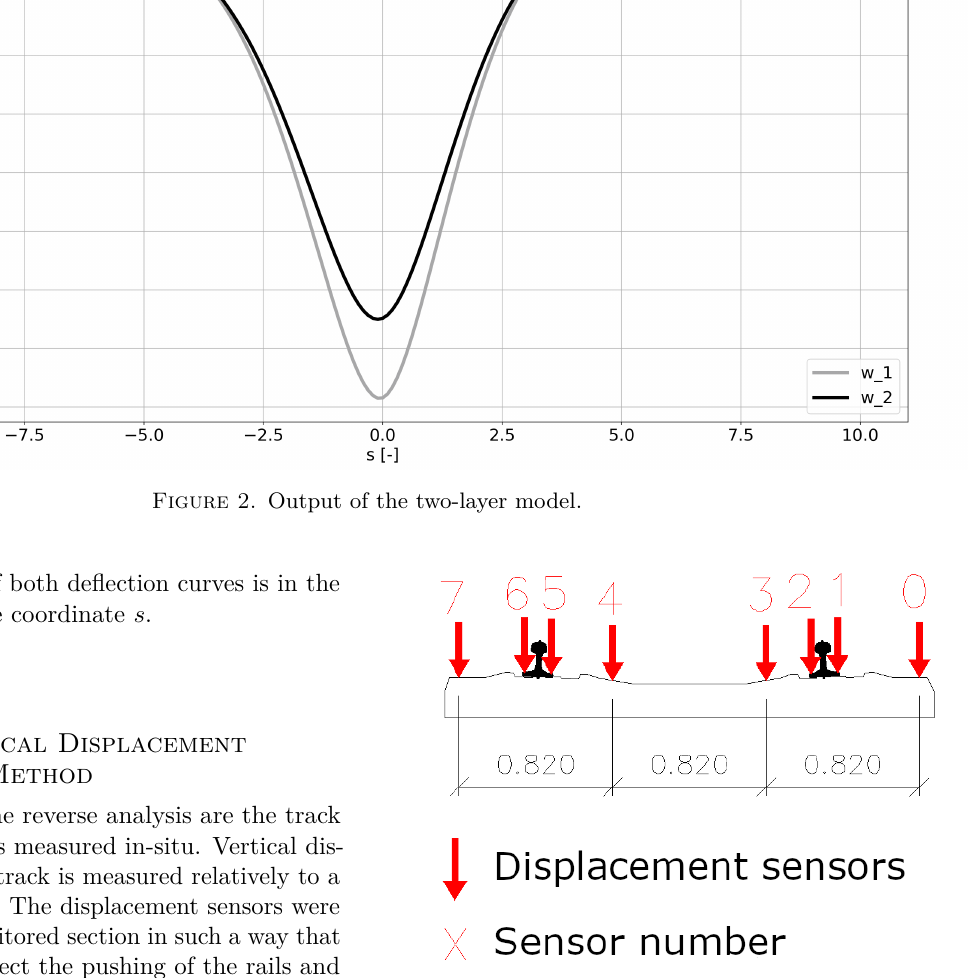
Figure 3. Schematic of sensor placement